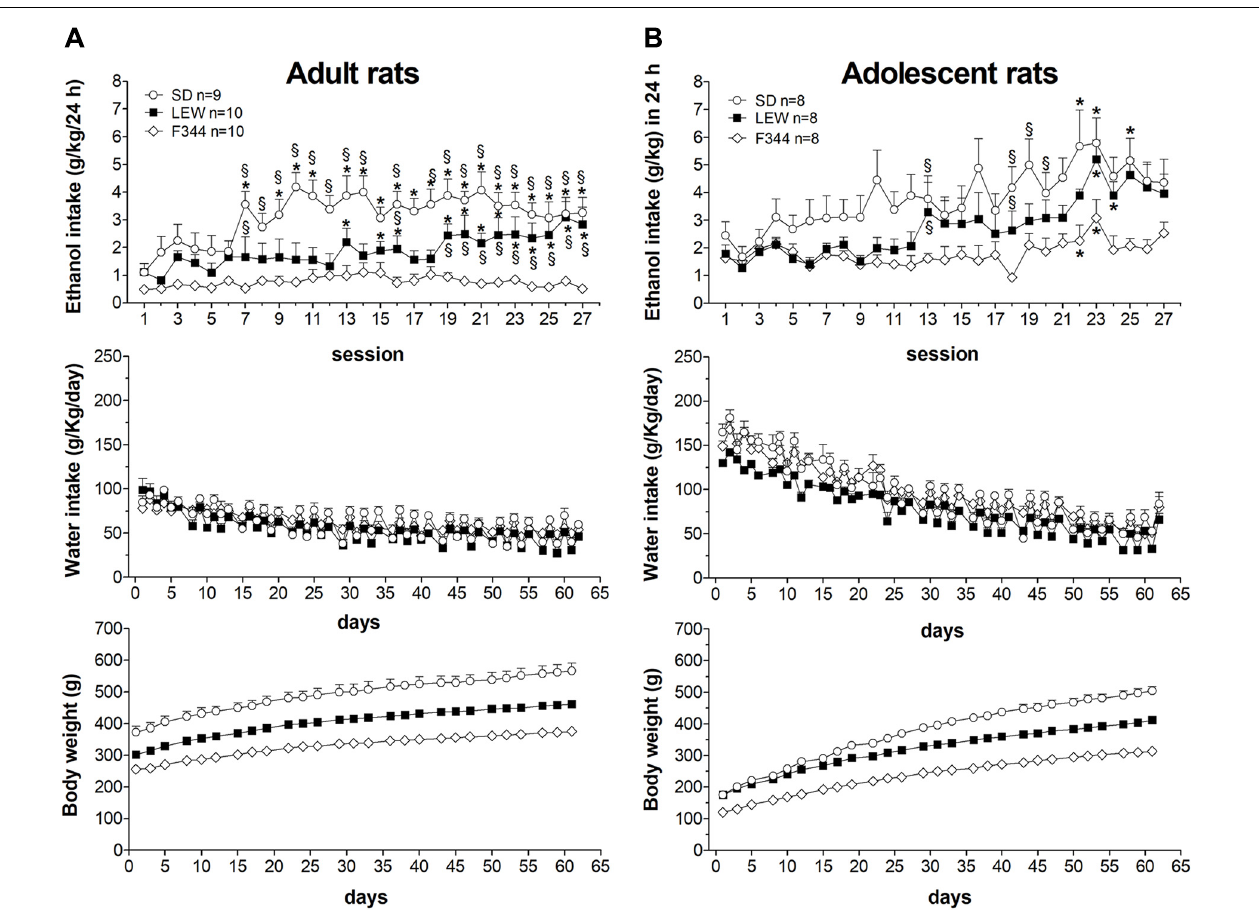
FIGURE 1 | Daily pattern of alcohol intake. Alcohol intake (g/kg/day) by adults (A) and adolescents (B) onset rats of Sprague-Dawley (SD), Lewis (LEW), and Fischer 344 (F344) strains and daily water intake (g/kg/day) during ethanol regimen. Lower panels show the body weight curves for the three strains during the entire experimental period. Results are expressed as means ± SEM. * p < 0.05 vs. first session within the same strain and § p < 0.05 vs. the corresponding value in the F344 strain by two-way ANOVA for repeated measures followed by Tukey’s post hoc